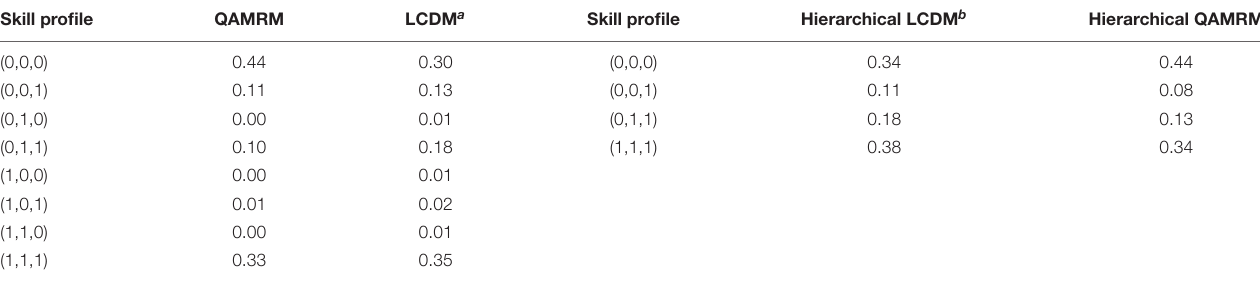
TABLE 5 | Skill profile distributions obtained for the QAMRM, LCMD.